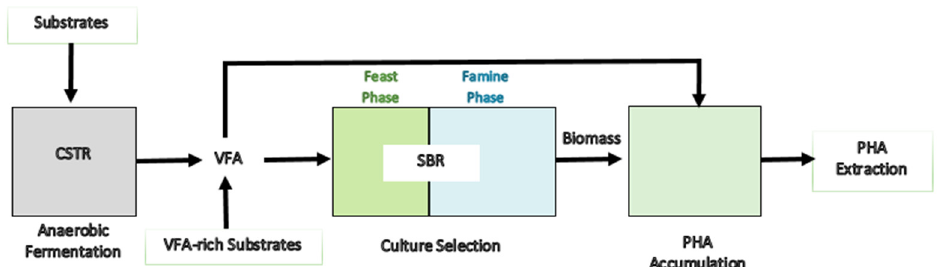
Figure 4. Three-stage process for PHA production through mixed microbial consortia (MMC). Modified from [85]. CSTR: continuous stirred tan reactor, SBR: sequential batch reactor.